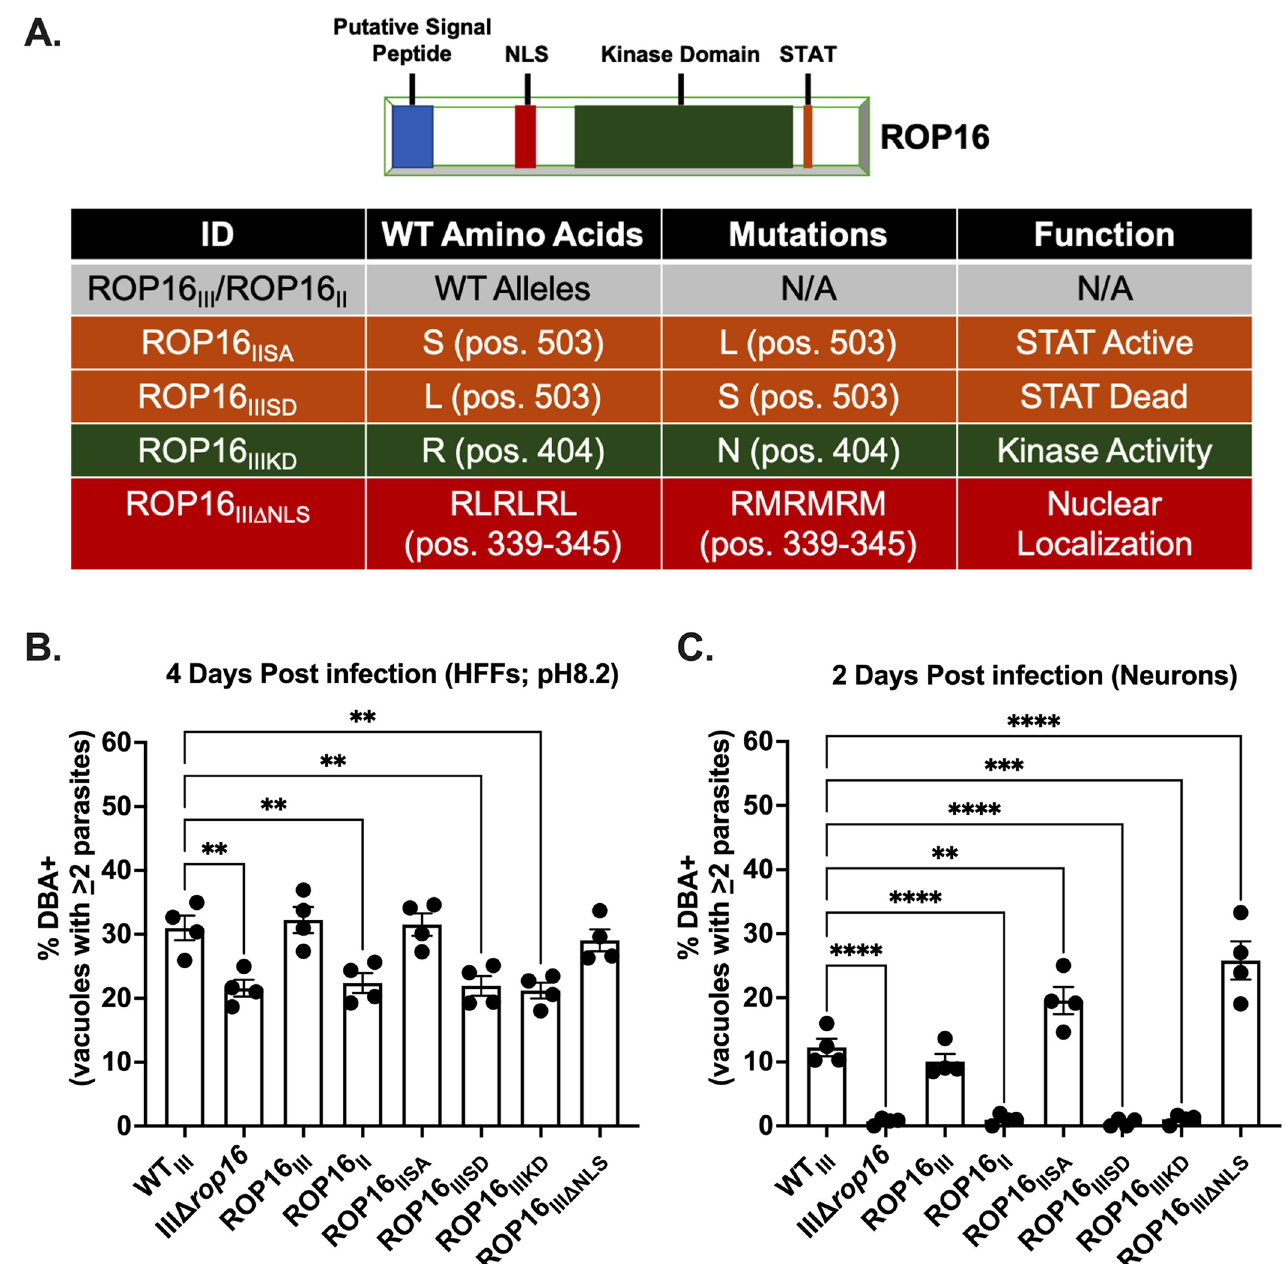
Fig 3. Efficient encystment requires a ROP16 with a functional kinase domain and a leucine at position 503. (A) Schematic of ROP16 and mutations in ROP16 constructs. (B) Quantification of encystment at 4 dpi in alkaline stress model of encystment. Bars, mean ± SEM. Black dots = Average % cyst for 1 experiment. N = 10 wells/experiment, 4 experiments total. (C) Quantification of encystment at 2 dpi in PNCs. Bars, mean ± SEM. Black dots = Average % cyst for 1 experiment. N = 3 wells/experiment, 4 experiments total. (B, C) ** p � 0.005, *** p � 0.0005, and **** p � 0.0001, one-way ANOVA, Dunnett’s multiple comparisons test compared to WT III